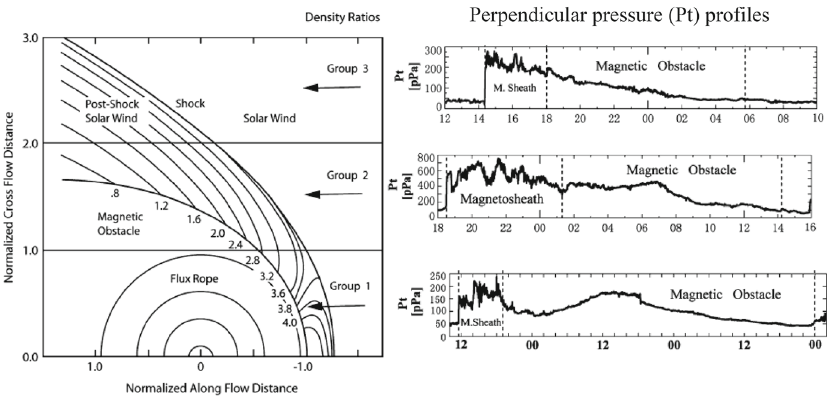
Fig.4 Differentspacecraftpaths(Group1–Group3)throughanICMEandthecorrespondingperpendicular pressure ( P t ) profiles. The different groups are described in the text. The contours in the figure show the density and the numbers give the density ratios between the solar wind and magnetopause values. In the right-hand part of the figure the first dashed line shows the shock and the following two dashed lines bound the ICME interval. Images reproduced by permission from Jian et al. (2006), copyright by